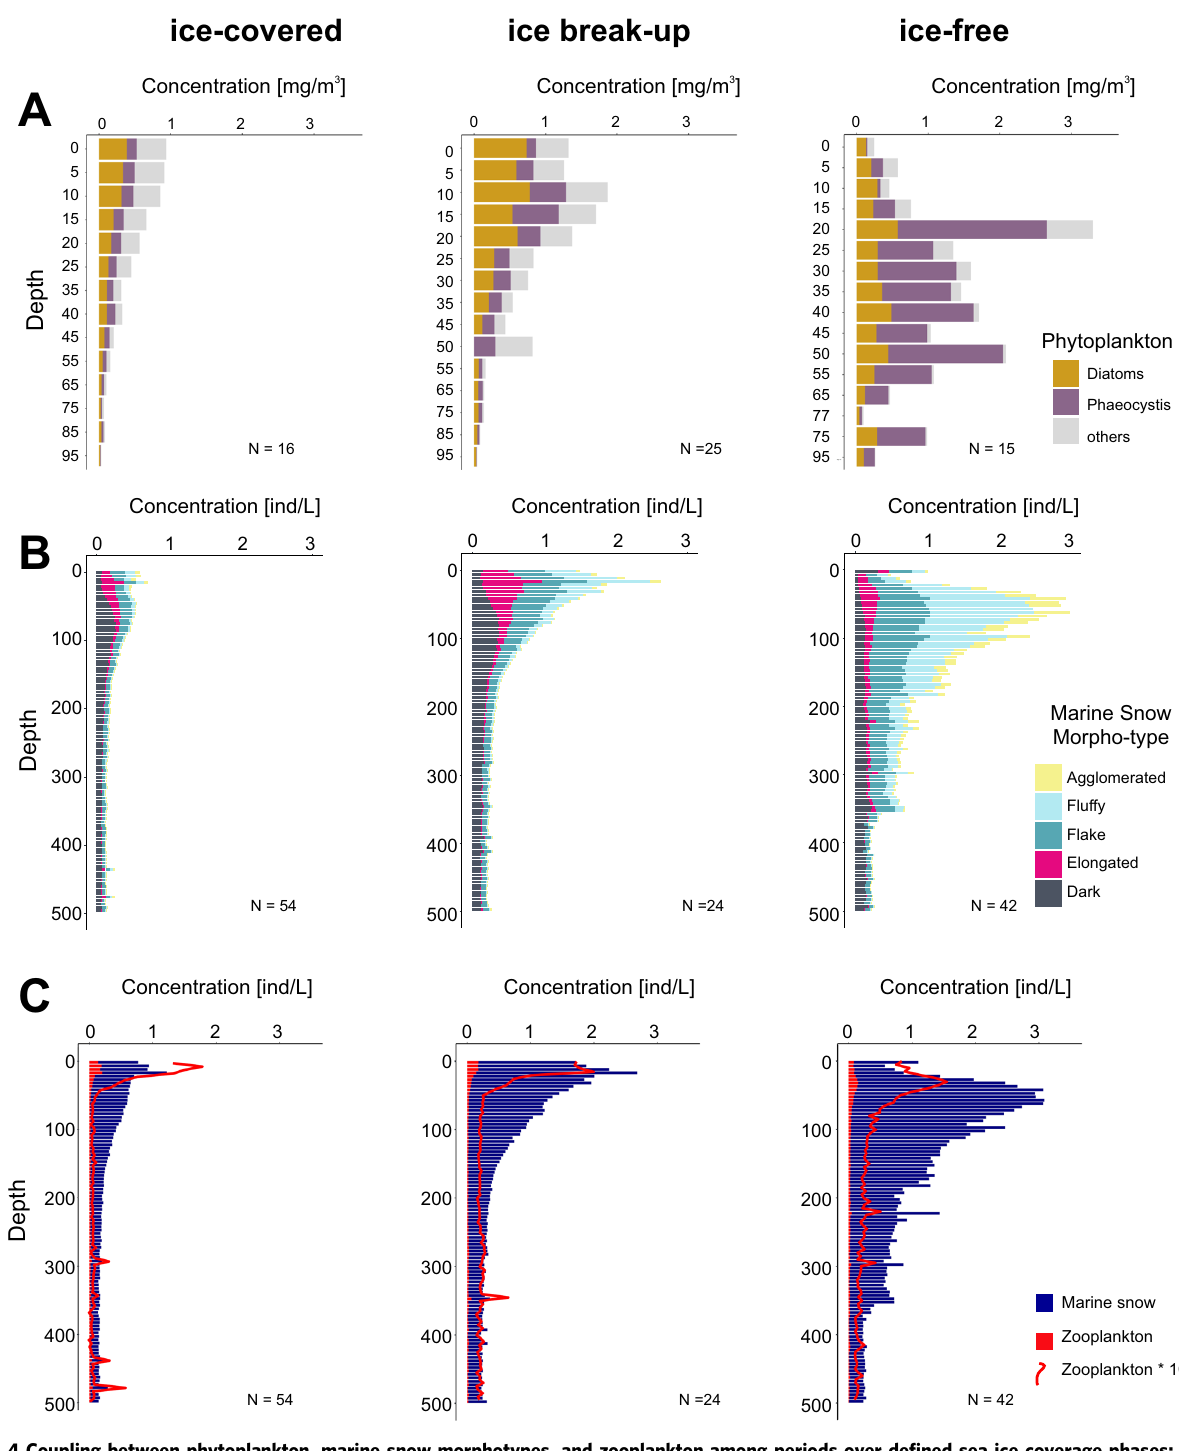
Fig. 4 Coupling between phytoplankton, marine snow morphotypes, and zooplankton among periods over de fi ned sea ice coverage phases: ice- covered (pre-bloom), ice break-up (bloom), ice-free (late bloom) in the Baf fi n Bay. A Pigment concentrations of dominant phytoplankton groups. B cumulative concentrations of different marine snow morphotypes. C total concentrations of marine snow and zooplankton. The red line highlights the distribution of zooplankton (the concentration multiplied by